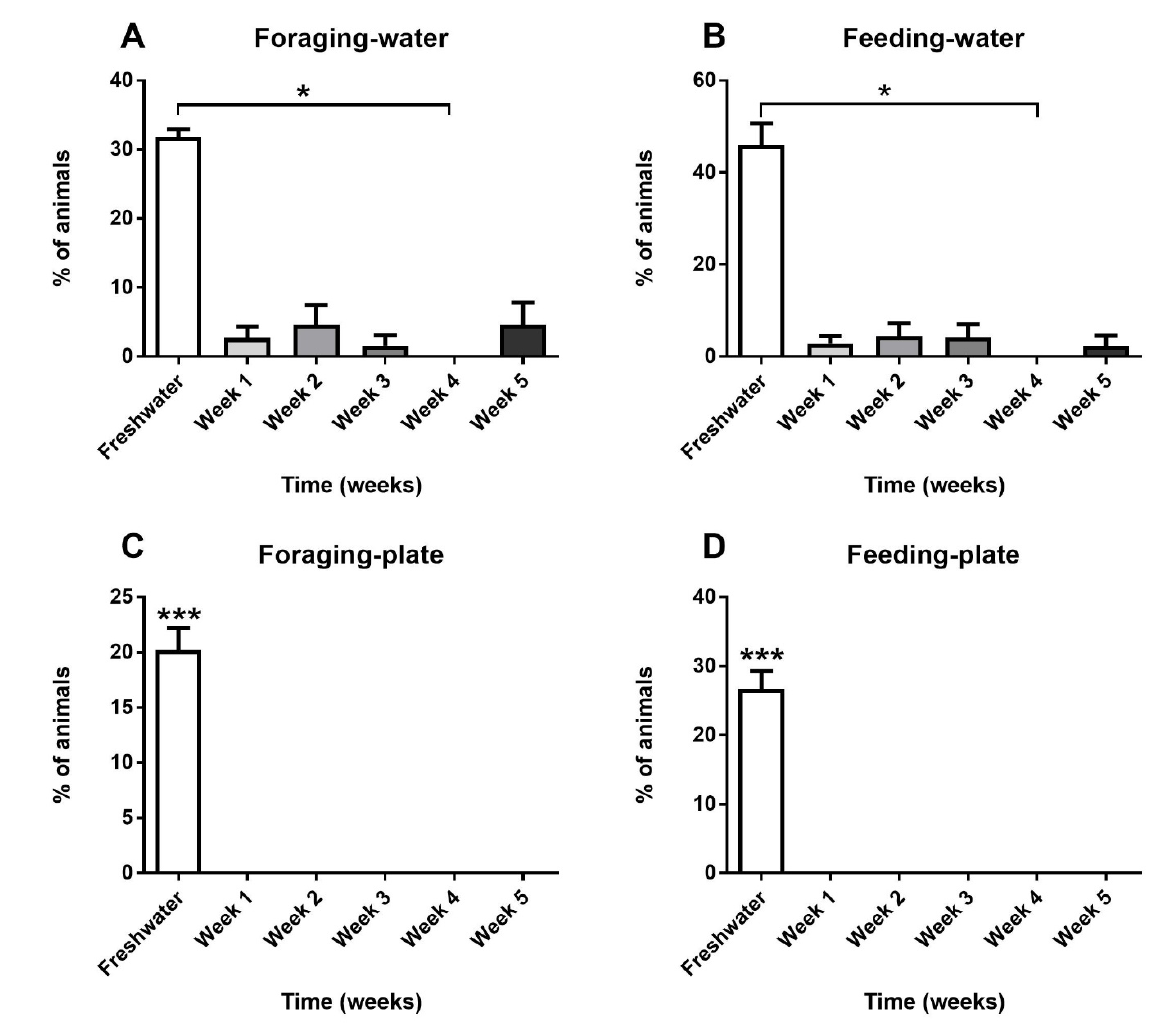
Percent Number of Alligators who Looked for Food in the Water (A) and on the Basking Plate (C) and Percent Number of Alligators that Ingested the Food in the Water (B) and on the Basking Plate (D) While in Freshwater and During a 5-week Exposure to 12‰